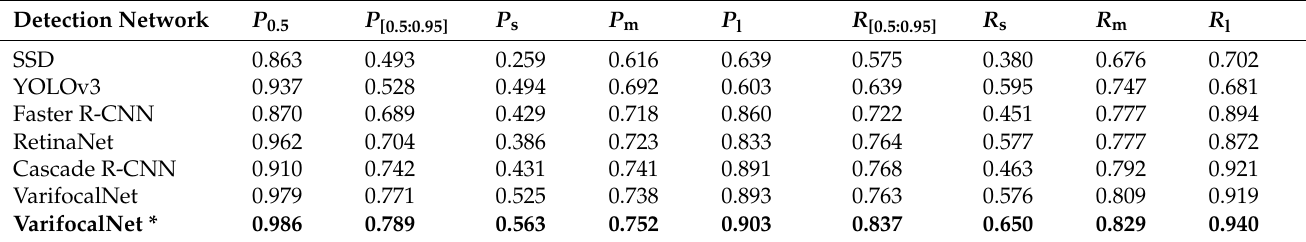
Table 3. Comparison of precision of each network